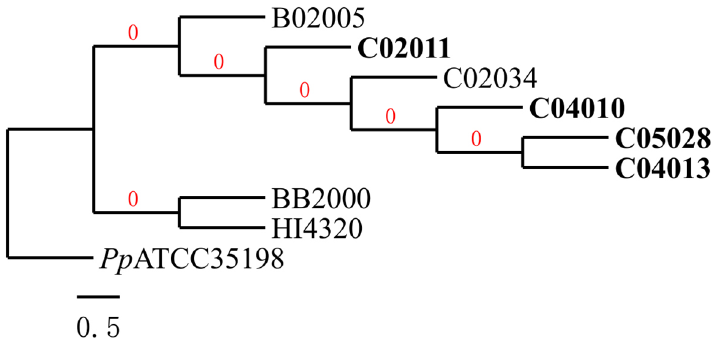
Fig 2. The phylogenetic tree of the seven P . mirabilis strains based on the 16S rRNA genes. The Cladogram tree is rooted at Proteus penneri ATCC 35198, and generated by the Phylogeny.fr. The three P . mirabilis strains inducing DTT function are highlighted in the bold